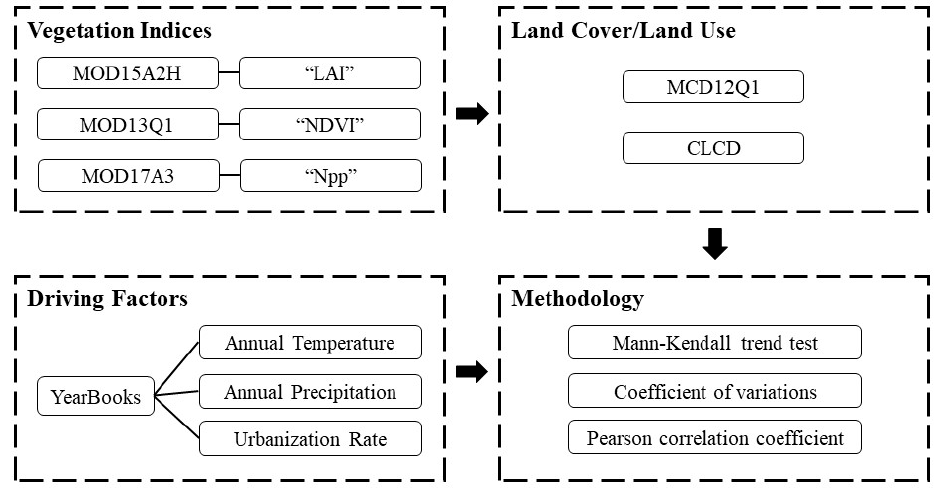
Figure 2. The workflow of this study.